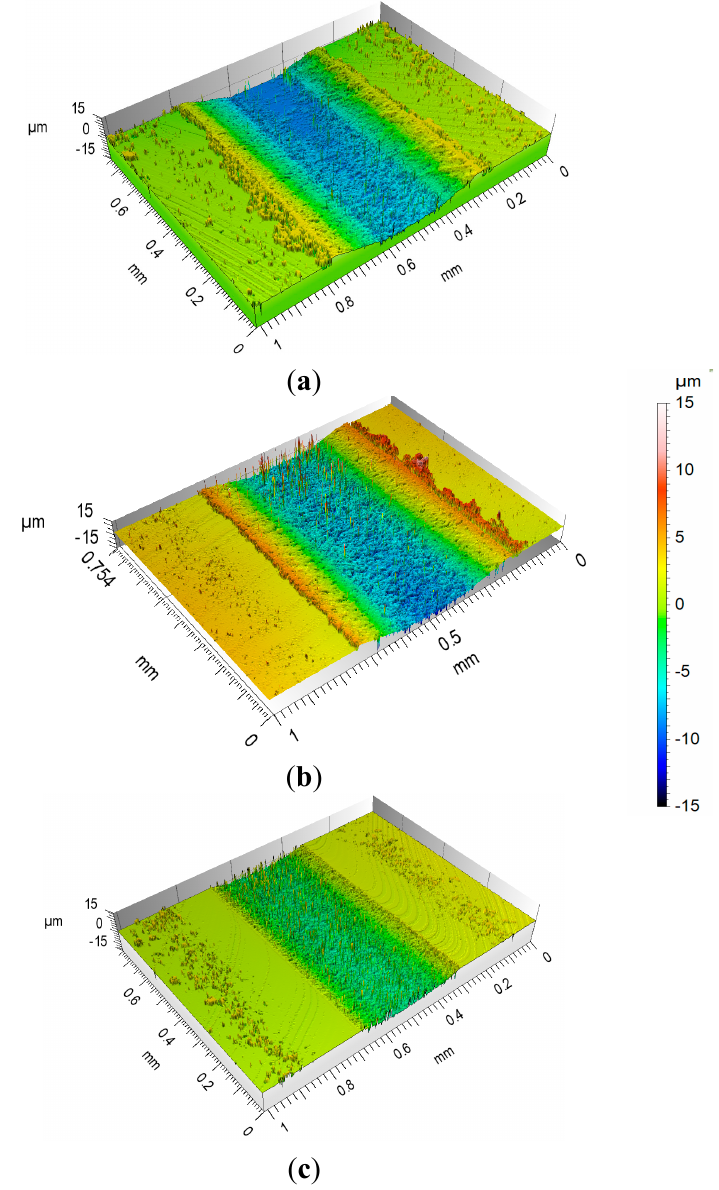
Figure 5. Optical 3D micrographs of wear tracks after 1800 cycles of ( a ) SU-8, ( b ) SU-8 + 4 wt % IL and ( c ) SU-8 + 10 wt %